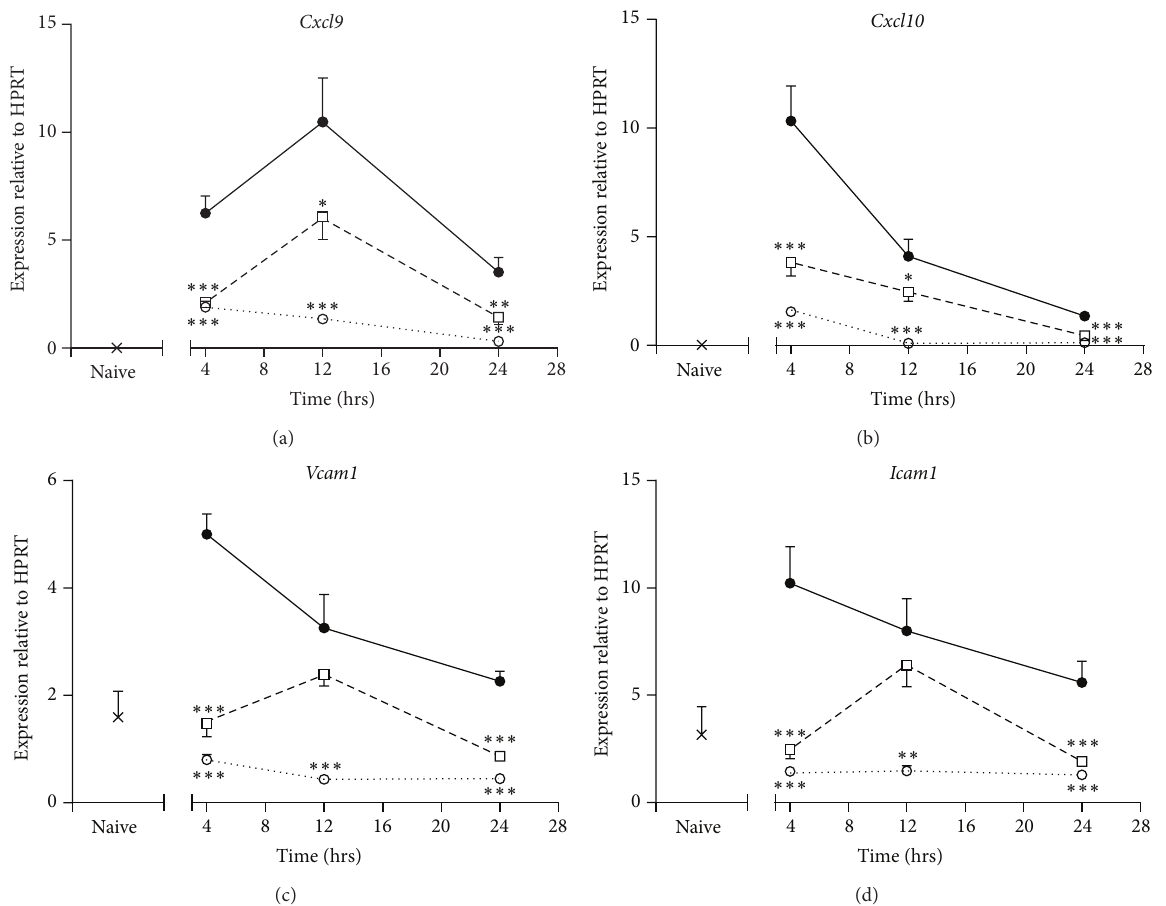
Figure 5: Effects of treatment with ISU201 on expression of mRNA for chemokines (a) Cxcl9, (b) Cxcl10 and adhesion molecules (c), Vcam1, and (d) Icam1 . Animals were treated with vehicle (— e —), ISU201 (-- ◻ --), or dexamethasone ( ⋅⋅⋅ I ⋅⋅⋅ ) at 2 and 8 hours after induction of an exacerbation. Data are mean ± SEM ( 𝑛 = 6 animals per group). Significant differences relative to vehicle-treated animals at each time point are shown as ( ∗ 𝑃 < 0.05 ), ( ∗∗ 𝑃 < 0.01 ), and ( ∗∗∗ 𝑃 < 0.001